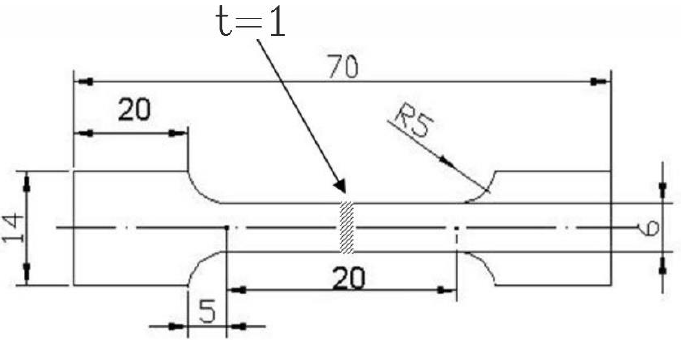
Figure 1. The tensile samples used in this paper. All dimensions are in